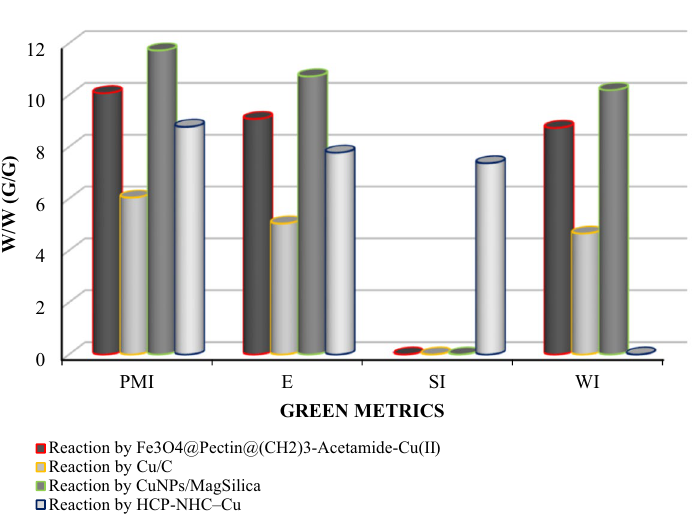
Figure 13. Green metrics including ( a ) AE, AEf, CE, RME, OE and ( b ) PMI, E, SI and WI for the one-pot Multi-component reaction of benzyl chloride, sodium azide, phenylacetylene, and catalyzed by Fe 3 O 4 @Pectin@ (CH 2 ) 3 -Acetamide-Cu(II) (this study), Cu/C (Table 2, entry 1), CuNPs/MagSilica (Table 2, entry 4) and HCP- NHC–Cu (Table 2, entry 7); W/W = Weight/Weight